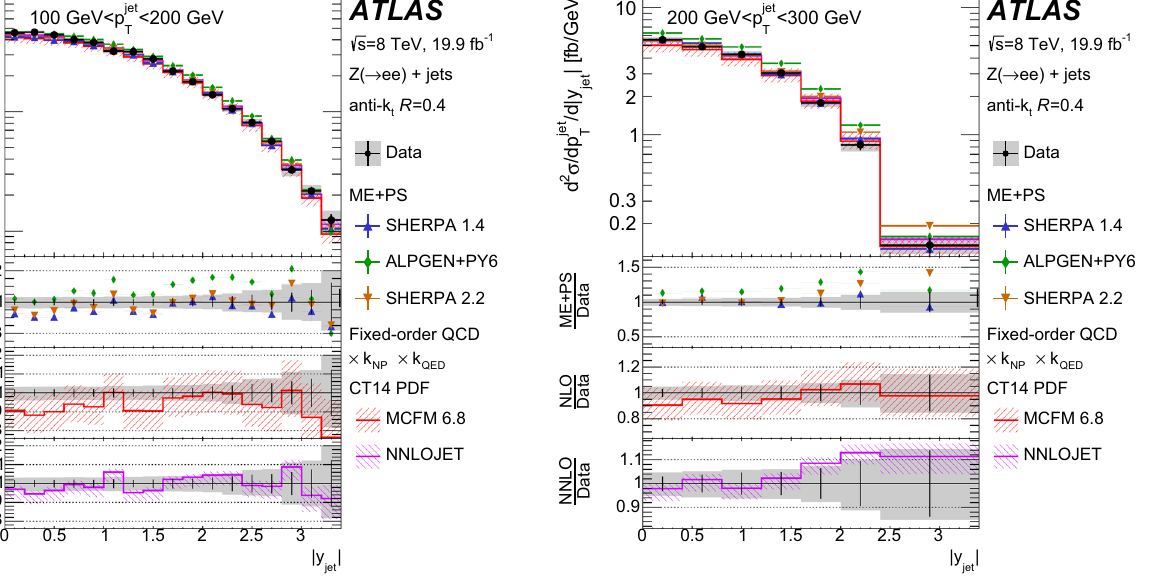
Fig. 9 The double-differential Z + jets production cross-section as a Fig. 10 The double-differential Z + jets production cross-section as a < 200GeV range. The data are < 300GeV range. The data are function of | y jet | in the 100GeV < p jet function of | y jet | in the 200GeV < p jet T T compared with the Sherpa v. 1.4, Sherpa v. 2.2 and Alpgen+Pythia compared with the Sherpa v. 1.4, Sherpa v. 2.2 and Alpgen+Pythia partonshowerMCgeneratorpredictionsandwiththefixed-ordertheory partonshowerMCgeneratorpredictionsandwiththefixed-ordertheory predictions.Thefixed-ordertheorypredictionsarecorrectedforthenon- predictions.Thefixed-ordertheorypredictionsarecorrectedforthenon- perturbativeandQEDradiationeffects.Thefixed-order calculationsare perturbativeandQEDradiationeffects.Thefixed-ordercalculationsare performed using the CT14 PDF. The total statistical uncertainties are performed using the CT14 PDF. The total statistical uncertainties are shown with error bars. The total uncertainties in the measurement and shown with error bars. The total uncertainties in the measurement and in the fixed-order theory predictions are represented with shaded bands. in the fixed-order theory predictions are represented with shaded bands. The total uncertainty in the measurement is the sum in quadrature of The total uncertainty in the measurement is the sum in quadrature of the statistical and systematic uncertainties except for the luminosity the statistical and systematic uncertainties except for the luminosity uncertainty of 1.9%. The total uncertainty in the fixed-order theory uncertainty of 1.9%. The total uncertainty in the fixed-order theory predictions is the sum in quadrature of the effects of the PDF, scale, and predictions is the sum in quadrature of the effects of the PDF, scale, and α α S uncertainties, and the uncertainties from the non-perturbative and S uncertainties, and the uncertainties from the non-perturbative and QED radiation corrections. Lower panels show the ratios of predictions QED radiation corrections. Lower panels show the ratios of predictions to data to